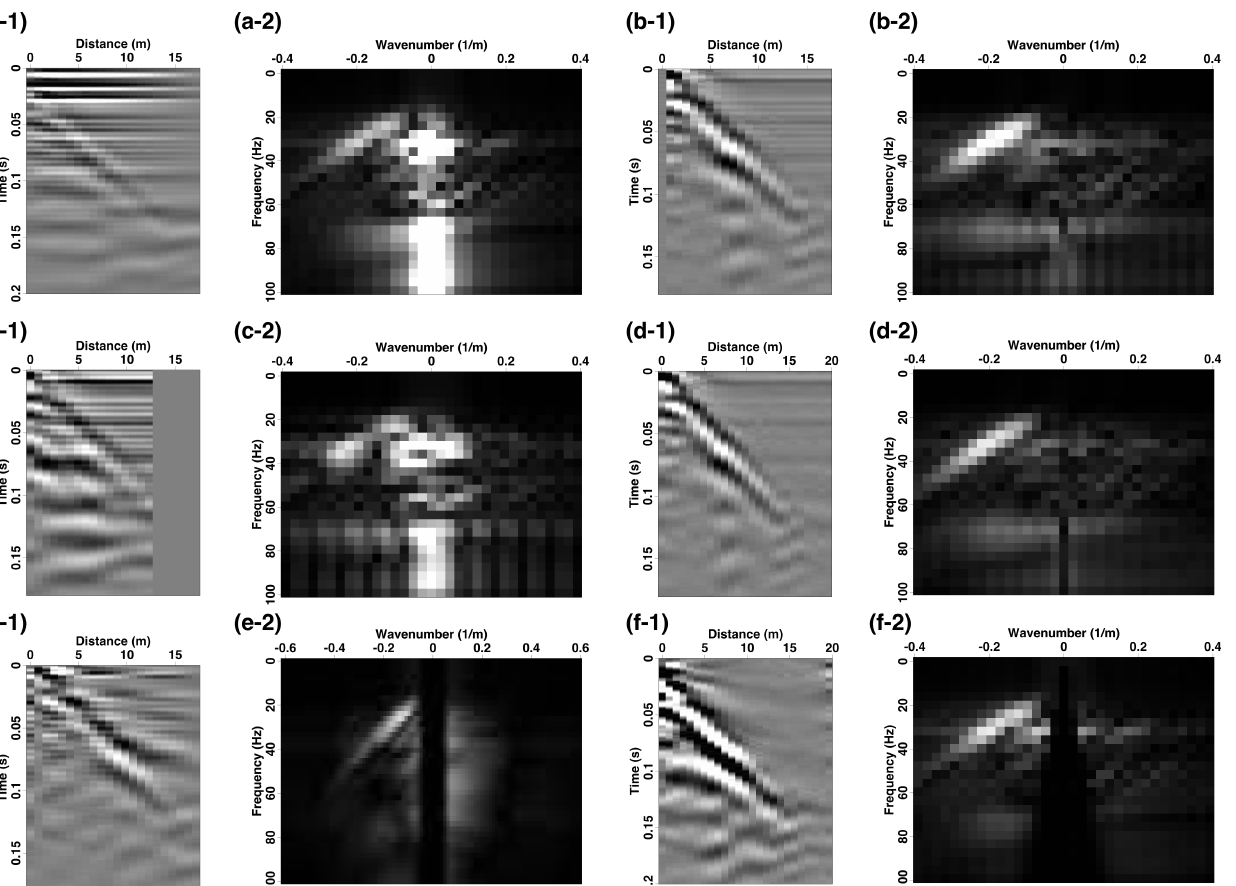
Figure 5. Data and f − k spectra for a shot gather recorded on Section A. ( a-1 ) Raw deformation-rate data and ( a-2 ) the associated f − k spectra. Strain-rate data with ( b-1 ) L G = 0.8 m and ( b-2 ) the associated f − k spectra. Strain-rate data with ( c-1 ) L G = 6.4 m and ( c-2 ) the associated f − k spectra. ( d-1 ) Strain-rate data after applying a 12th-order accurate numerical first-derivative filter as shown in Figure 4e and ( d-2 ) the associated f − k spectra. ( e-1 ) 1D low-cut Butterworth filter and ( e-2 ) the associated f − k spectra. ( f-1 ) 2D velocity-dip filtering and ( f-2 ) the associated f − k